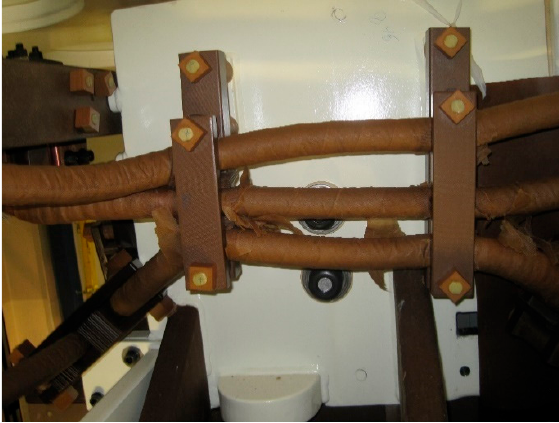
Figure 1. Damaged insulation during short circuit test.